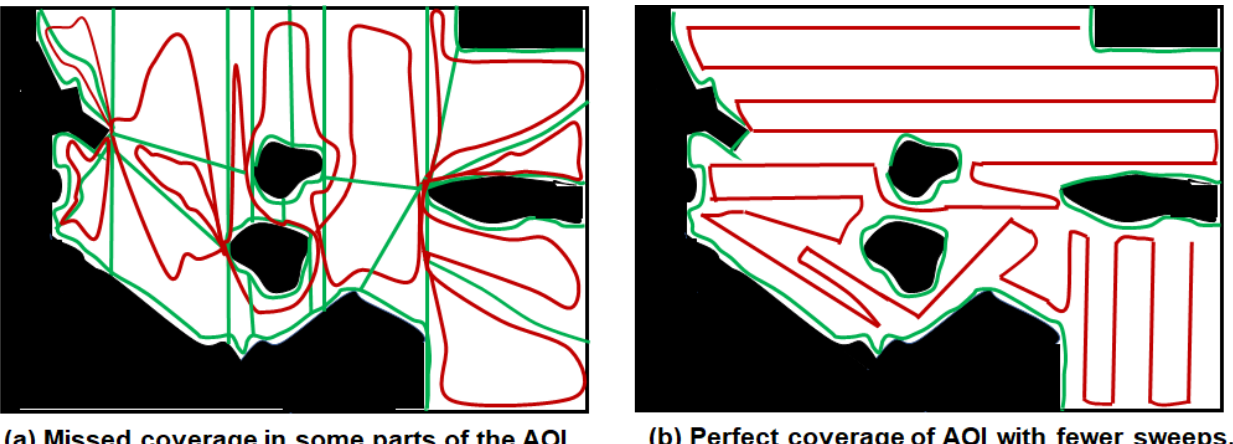
Figure 16. Perfect coverage of the AOI with a path with fewer turns ( b ) compared to the decomposition-based methods ( a